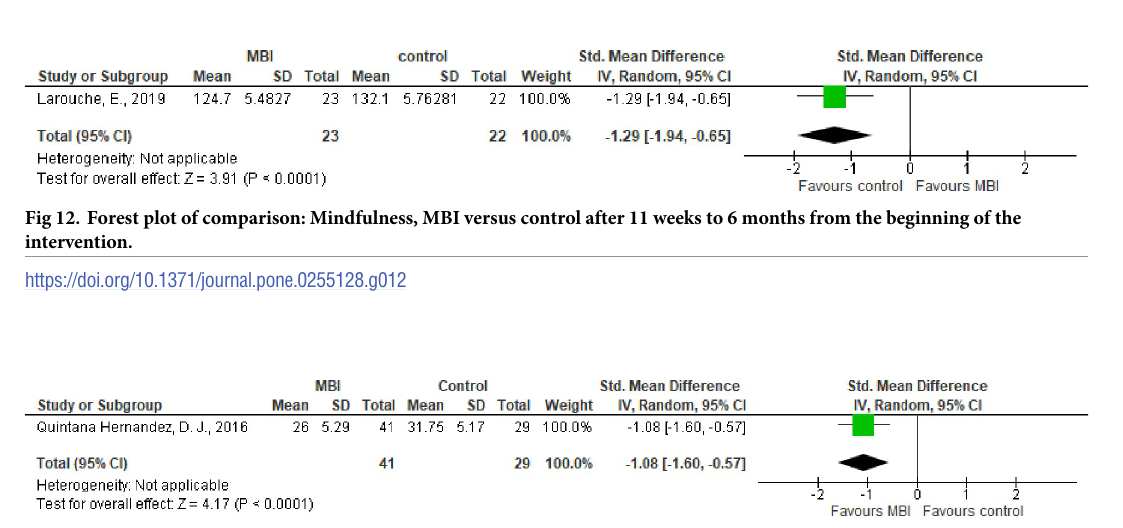
Fig 13. Forest plot of comparison: ADL, MBI versus control after 11 weeks to 6 months from the beginning of the